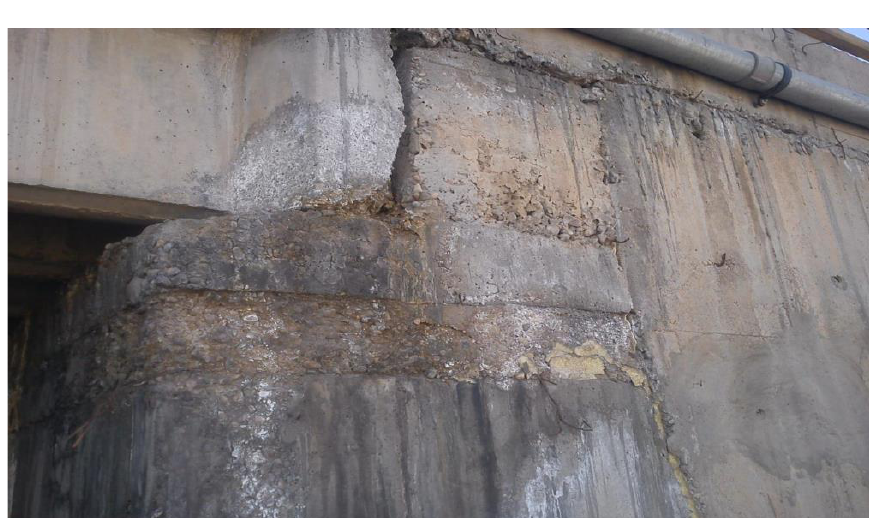
Figure 15. The pavement condition of bridge No. 3.